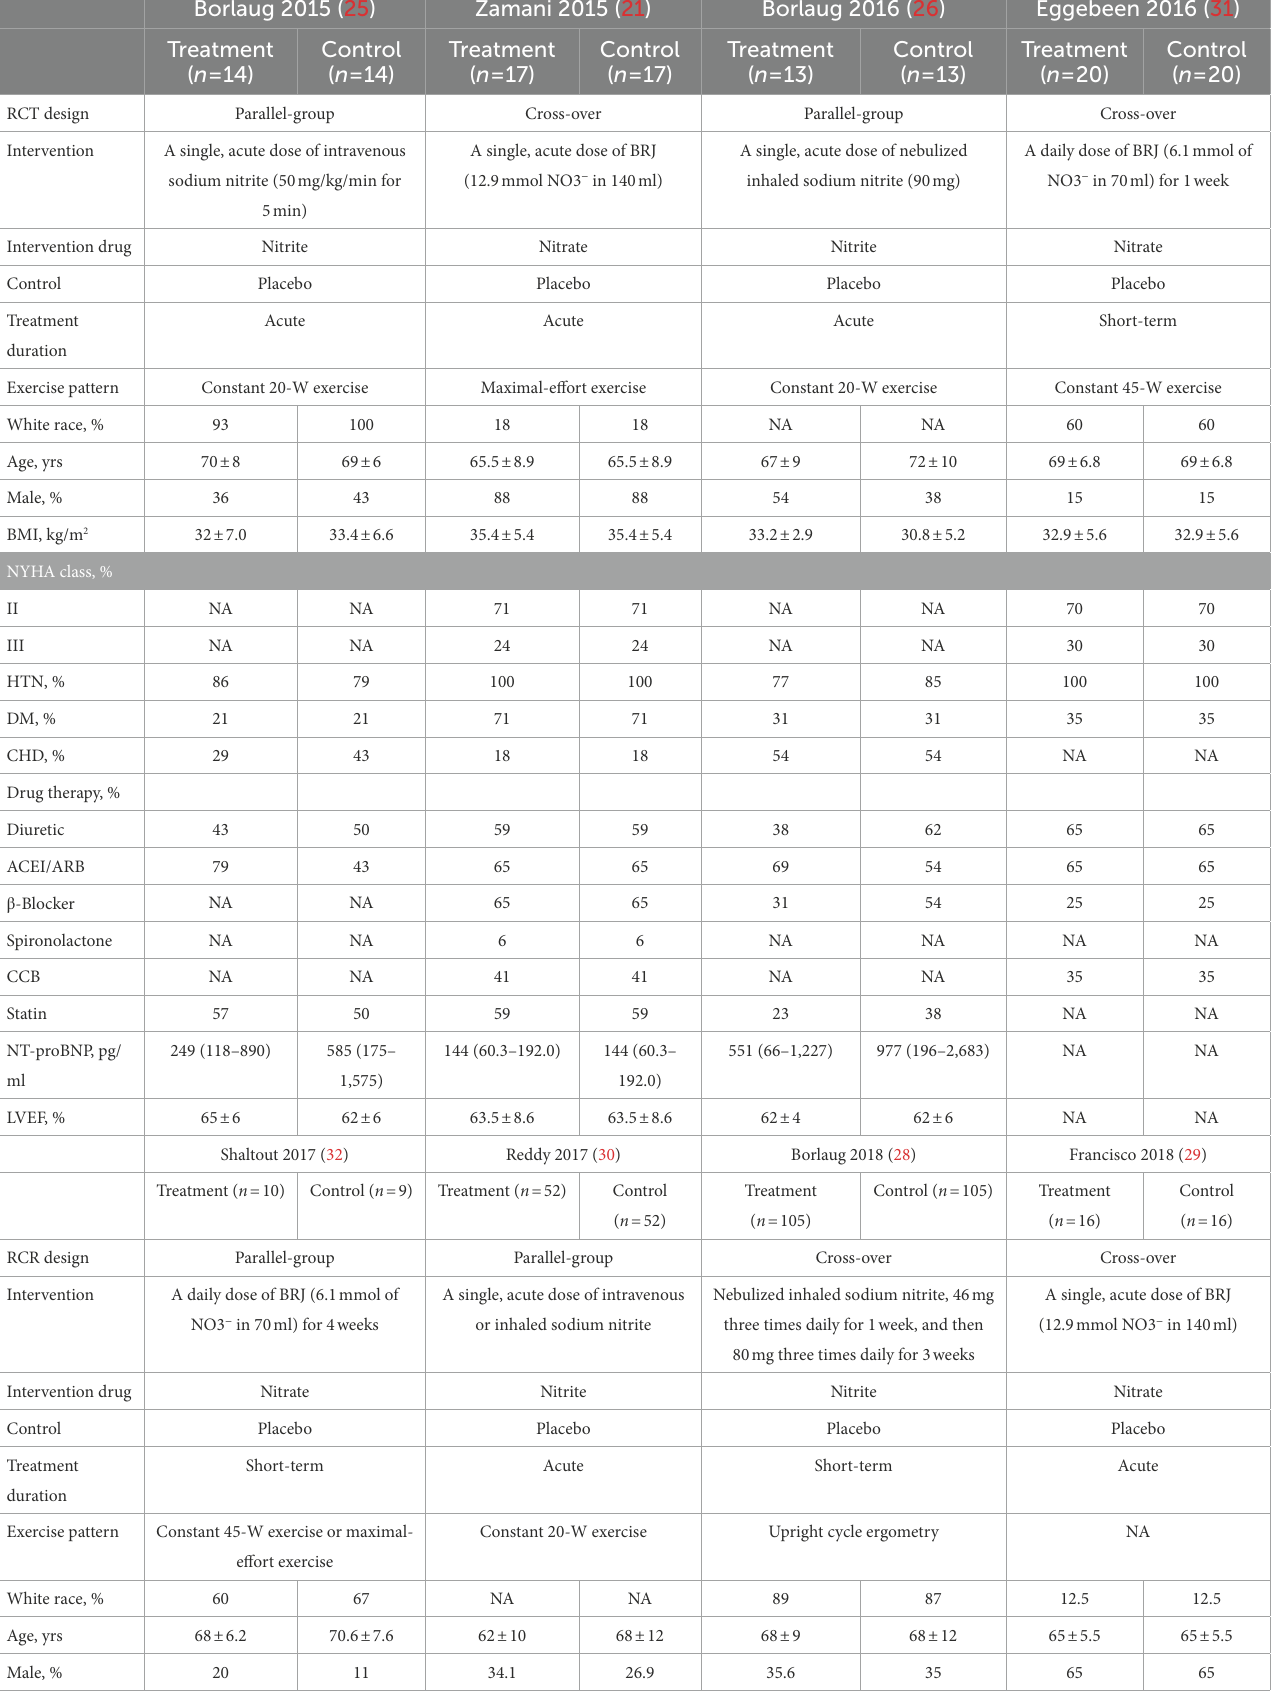
TABLE 1 Characteristics of studies included in the meta-analysis. Borlaug 2015